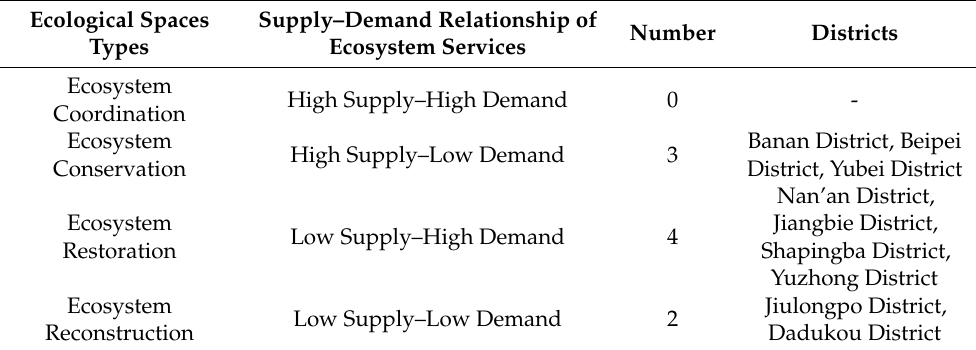
Table 3. Classification of different districts based on supply–demand relationships. Ecological Spaces